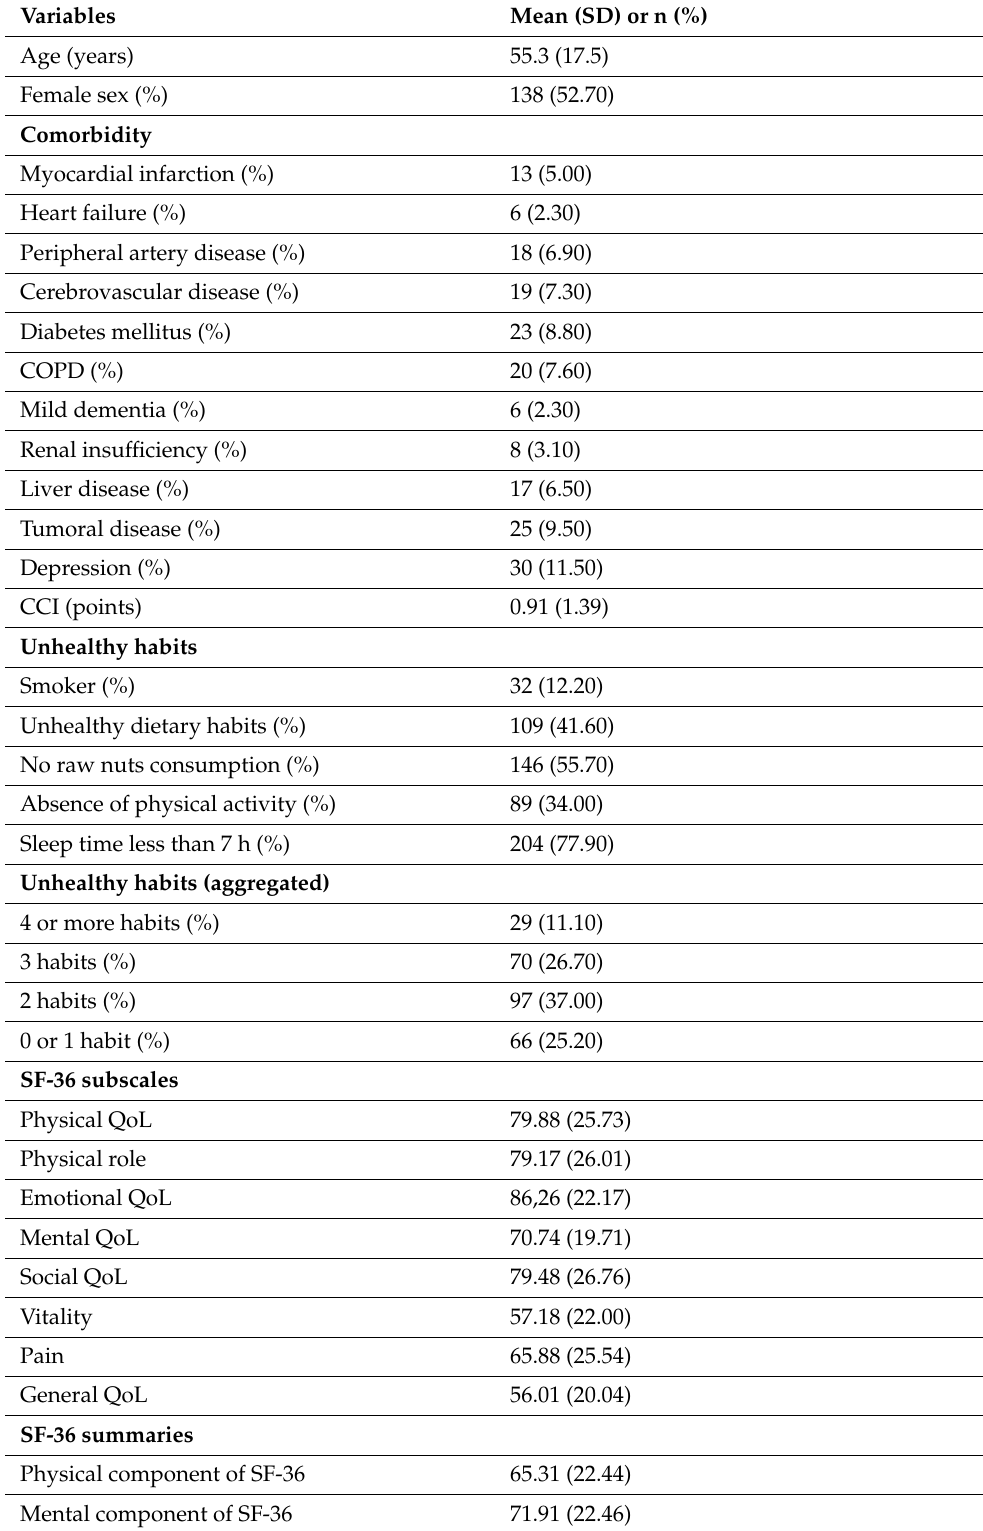
Table 1. Population demographic, comorbidity, lifestyle and QoL characteristics (n =